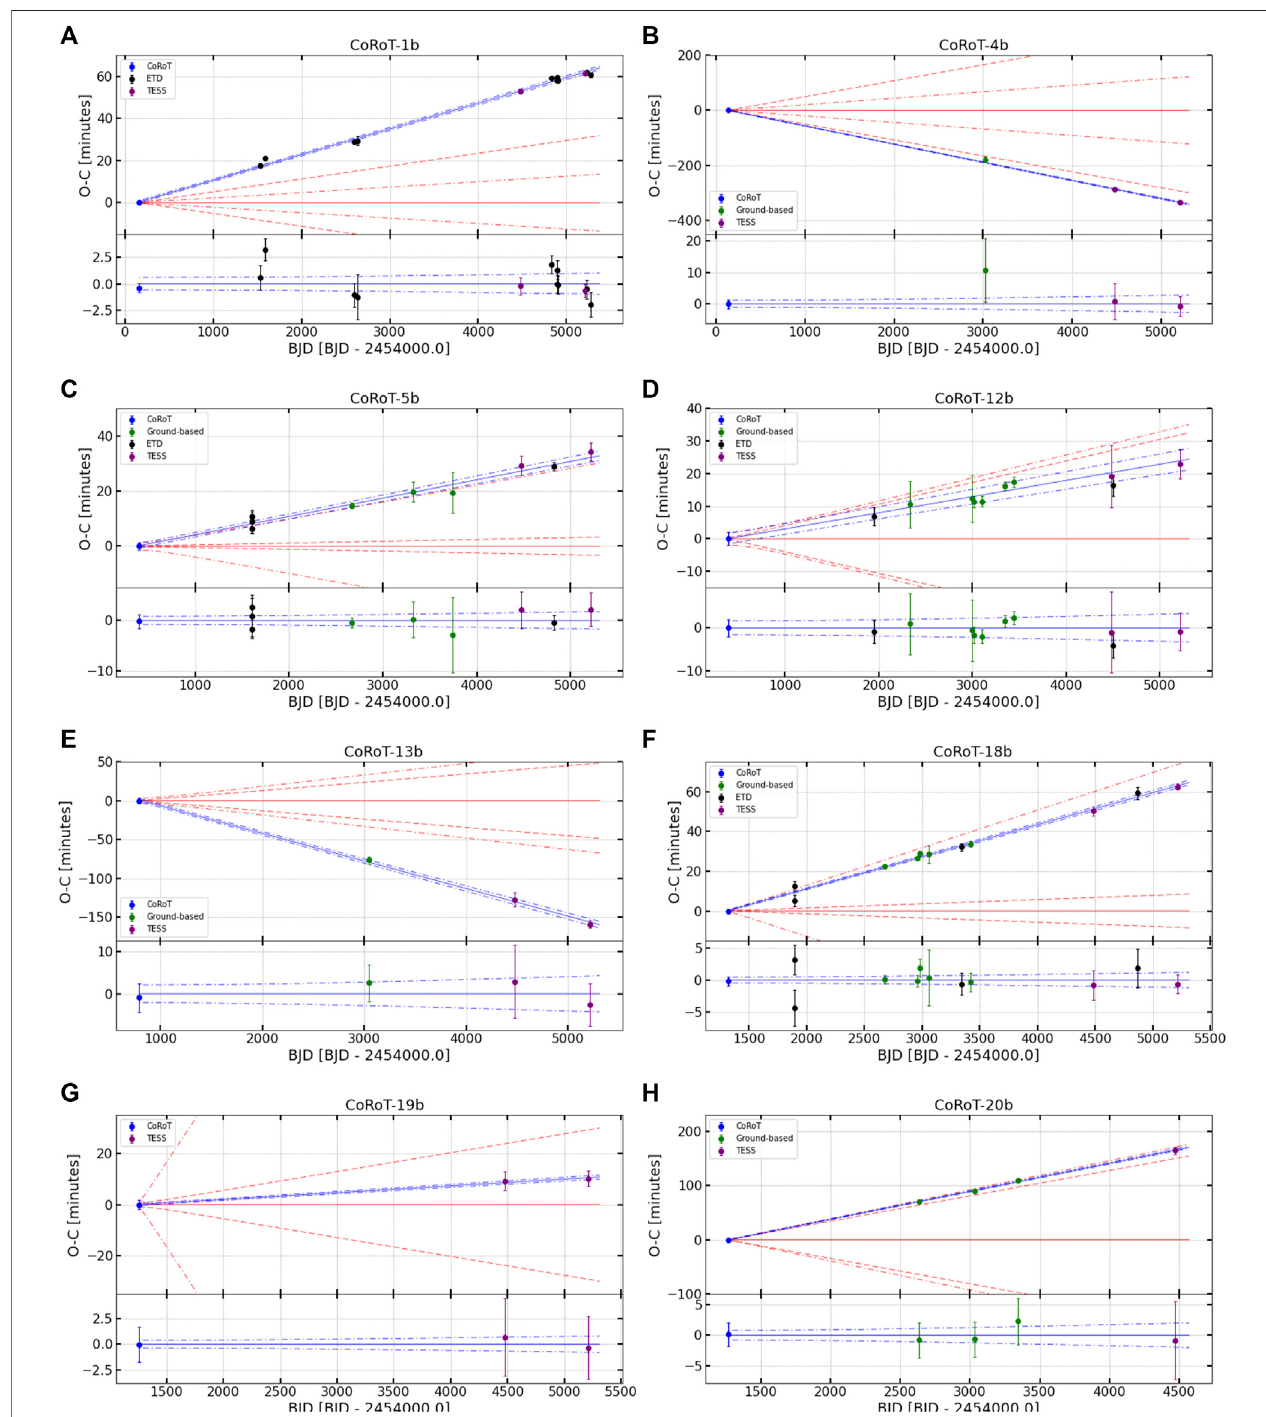
FIGURE2| O-Cdiagramsoftheplanets ’ transits,againstthediscoveryephemeris (upperpartofeachpanel) andagainsttherevisedephemeris (lowerpart) .In each panel, the blue dot on the left is the CoRoT measurement, green dots represent any ground-based observation, while the purple dots correspond to TESS observations in Sectors 6 and 33. The red lines refer to timing predictions based on the original ephemeris, where the dashed and the dash-dotted lines correspond to the original and the standard timing errors, respectively. The blue solid line represents the updated ephemeris, with its errors shown as dash-dotted lines. For CoRoT-7b, see Figure 4